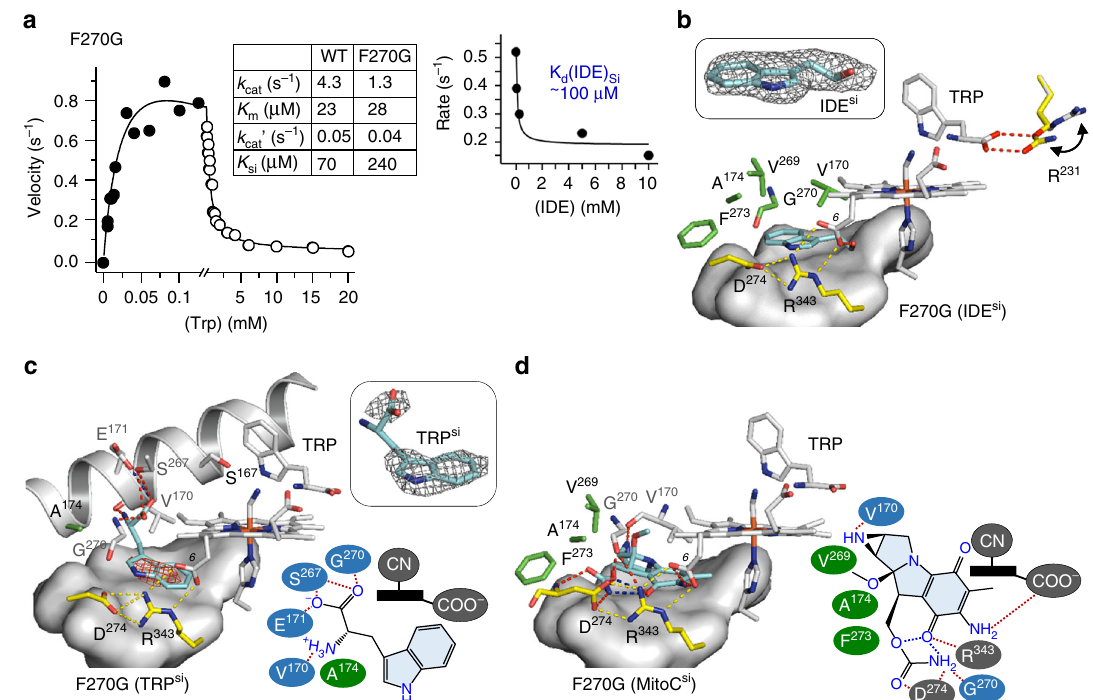
Fig. 4 Evidence supporting the Si site as an inhibitor-binding site. a Steady-state activity of the F270G mutant of hIDO1. The kinetic constants obtained by fi tting the data with the two-Trp-binding sites model are summarized in the table in the inset, where the wild-type enzyme data are listed as a reference. The right inset displays the activity of F270G as a function of [IDE]. In contrast to that observed in the wild-type enzyme, IDE binding inhibits the activity; in addition, only one IDE-binding event, with a K d (IDE) of ~100 μ M, was observed. The inhibition effect is attributed to IDE binding to the Si site, not the Sa site, based on two observations: (i) the K d is similar to the K d (IDE) si of the wild-type enzyme (~200 uM), and (ii) the crystal structure shown in b demonstrates that, when IDE and Trp coexist, IDE preferentially occupies the Si site. b Crystal structure of the F270G-CN-Trp complex in a mixed ligand state, where the Sa and Si sites are occupied by Trp and IDE, respectively. The 2Fo-Fc map of the Si site IDE in the inset is contoured at 1.0 σ . The surface representation shows the hydrophobic base of the Si site built by L207, L339, L342, A210, and F214. c Crystal structure of the F270G-CN-Trp complex in a two Trp-bound state, where both the Sa and Si sites are occupied by Trp. The red mesh represents the simulated annealing omit map of the Si site Trp contoured at 1.0 σ . The top right inset shows the 2Fo-Fc map of the Si site Trp contoured at 1.0 σ . The bottom right inset shows a schematic illustration of the Trp-protein interactions in the Si site. d Structure of the F270G mutant in complex with mitomycin C (MitoC) obtained by molecular docking studies. The right inset illustrates the predicted MitoC-protein